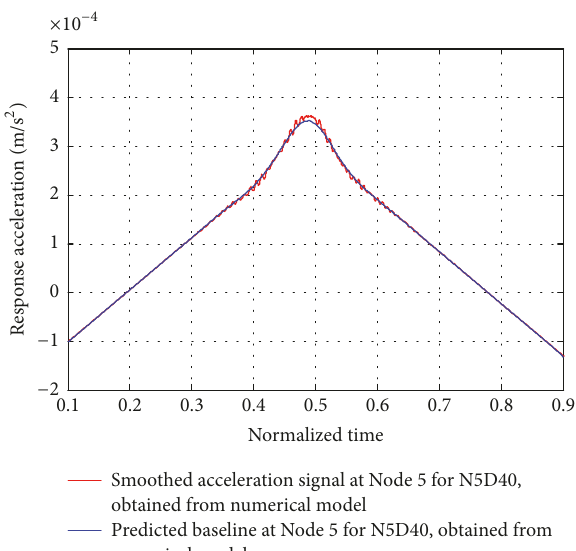
Figure 10: The smoothed acceleration signal obtained at Node 5 with delta = 40% (red color) and its predicted baseline based on MAF (blue color).